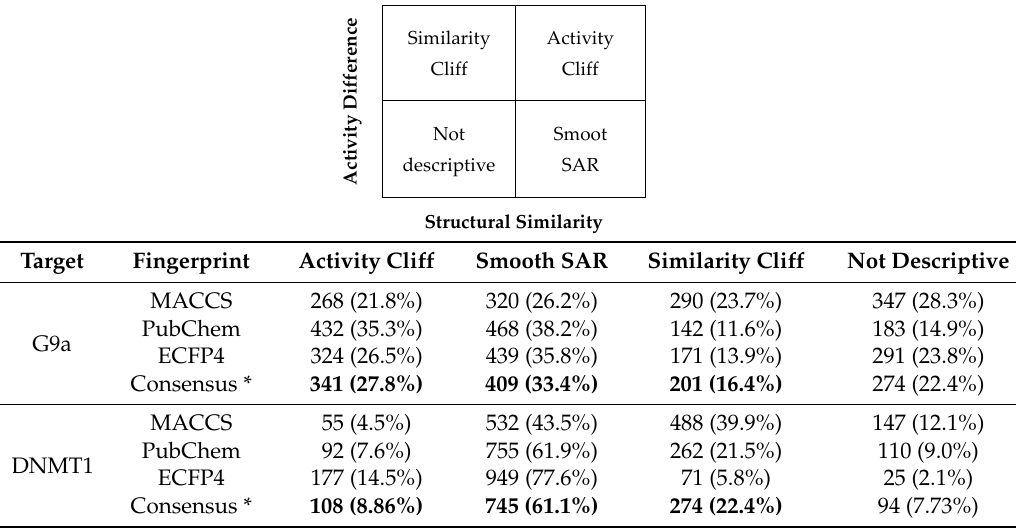
Table 1. Summary of quantitative analysis of the SAS map for G9a and DNMT1.